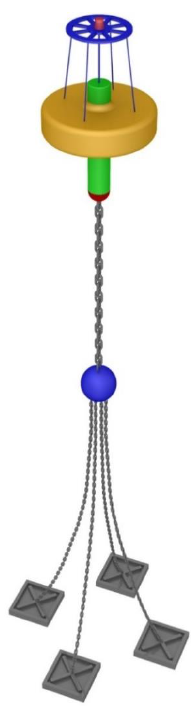
Energies 2016 , 9 , 850 7 of 16